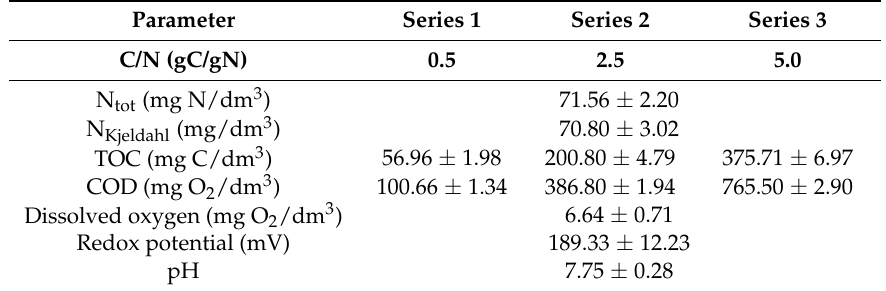
Table 1. Average ( ± SD) values of raw wastewater concentration in subsequent research Table 1. Average (±SD) values of raw wastewater concentration in subsequent research series.